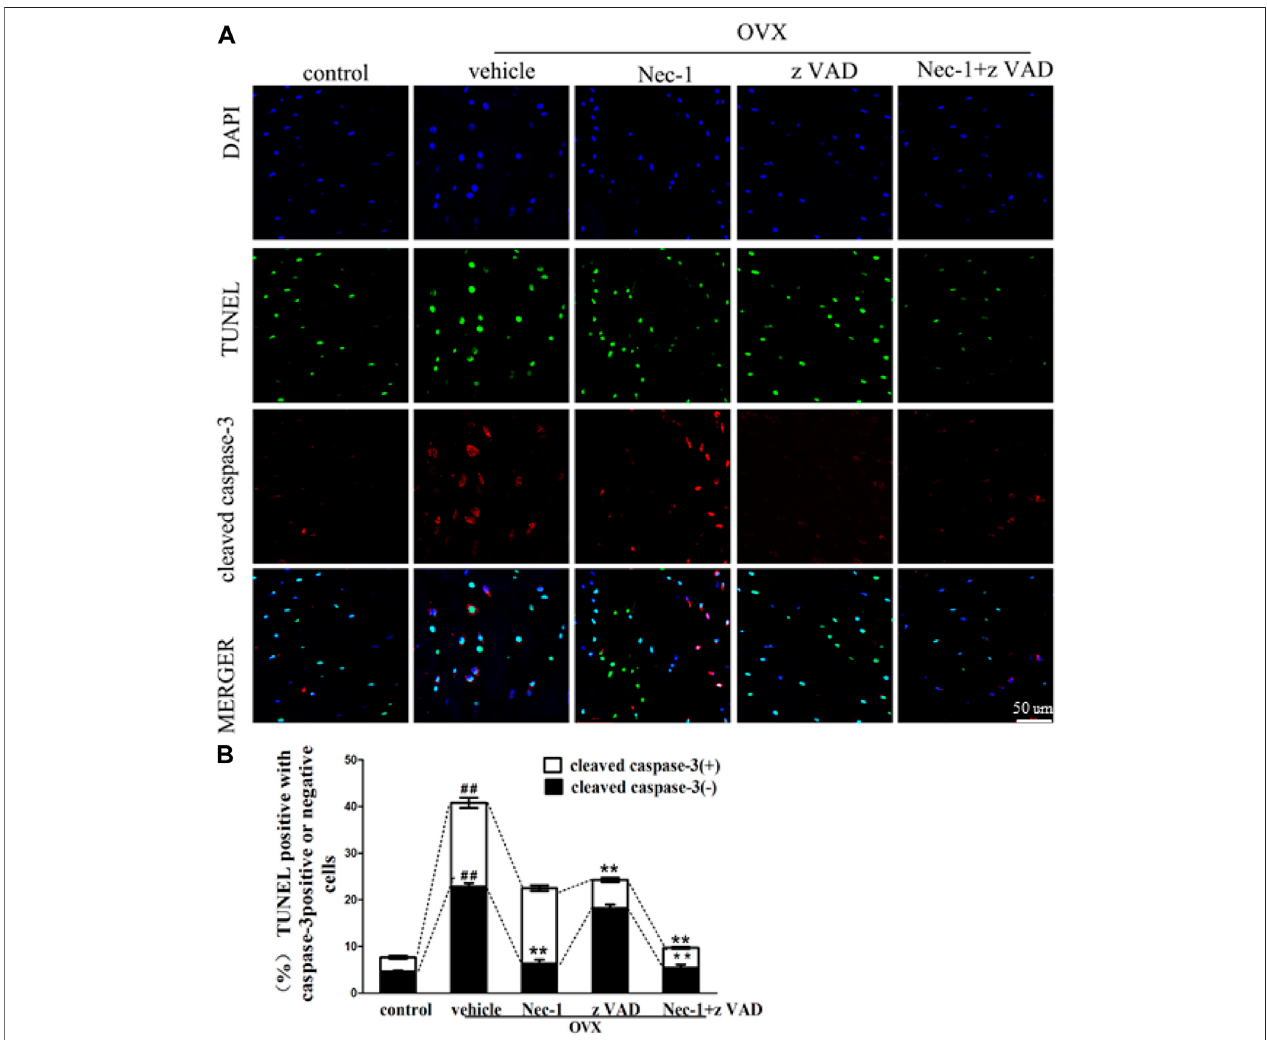
FIGURE 2 | Osteocyte death was analyzed by the TUNEL method. (A) Immuno fl uorescence analysis of cleaved caspase-3 (red), in situ fl uorescence TUNEL (green),andDAPI(blue)stainingwereperformedinthebonematrixofthetibialplateaupretreatedfor30 minwithDMSO(1%),Nec-1(30 mmol/L),zVAD(25 mmol/L),or Nec-1 (30 mmol/L) + zVAD (25 mmol/L) (scale bar, 50 μ m). (B) Quanti fi cation of TUNEL-positive cells with or without cleaved caspase-3 was conducted in the bone matrix of the tibial plateau (n (cid:1) 6). ## p < 0.01 compared with the control group, * p < 0.05 compared with the vehicle group, ** p < 0.01 compared with the vehicle